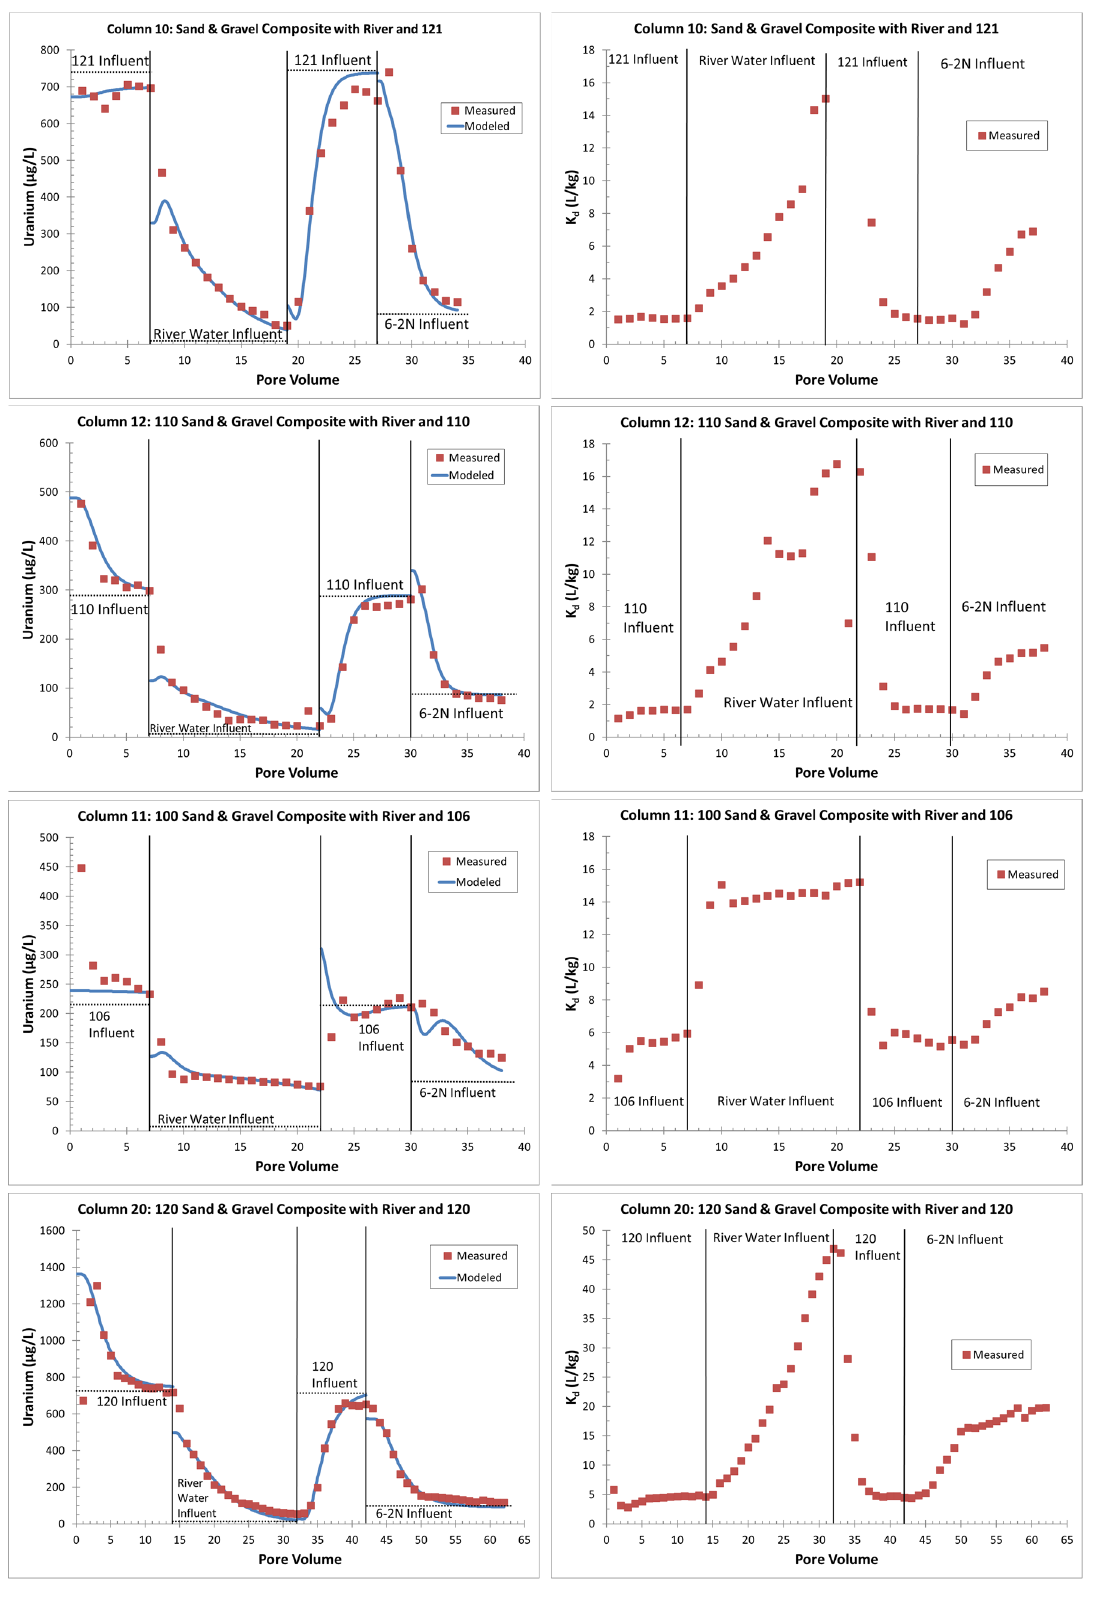
Figure 9. Representative saturated-zone columns with measured versus modeled effluent uranium concentrations and calculated K d values (initial solid-phase uranium values from Table 3). L/kg = Liters of water per kilogram of sediment; note variable scales between columns.